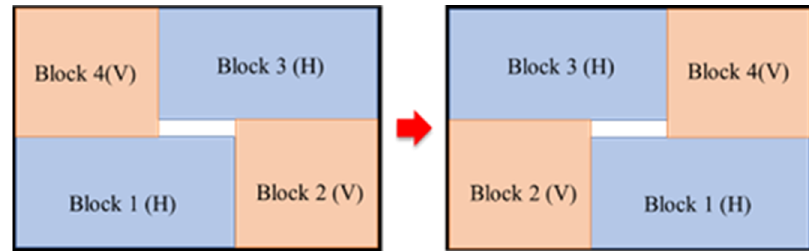
Figure 21. Mirror